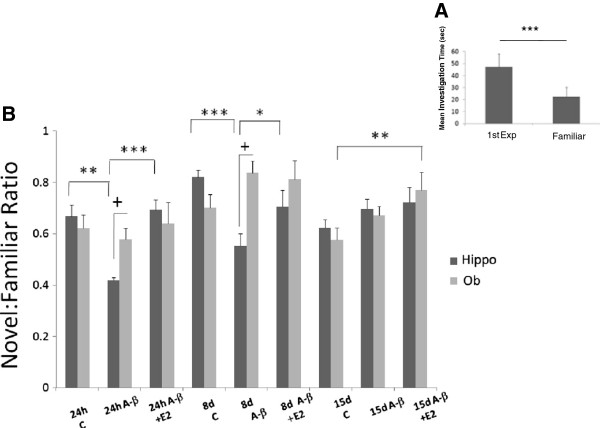
Olfactory memory acquisition. A. Olfactory memory acquisition in social investigation, control group. B. Ratios of time investigating the familiar or the unfamiliar juvenile rat. Adult ovariectomized female rats tested at 60 min IEI. Control groups (vehicle) evaluated at 24 h, 8 and 15 days after vehicle injection. Experimental groups injected with A-β25-35 and A-β +E2. HIPP (black columns) or OB (grey columns) evaluated at same times as control groups. *P < 0.05; **P < 0.01; ***P < 0.001, comparison intergroup. +P < 0.05 comparison between OB and HIPP groups.